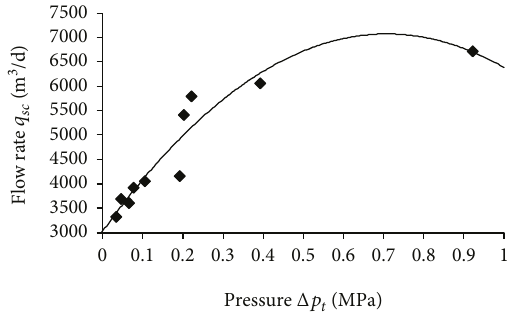
Figure 5: E ff ect of CBM and water column pressure on CBM production in two-phase producing wellbores.